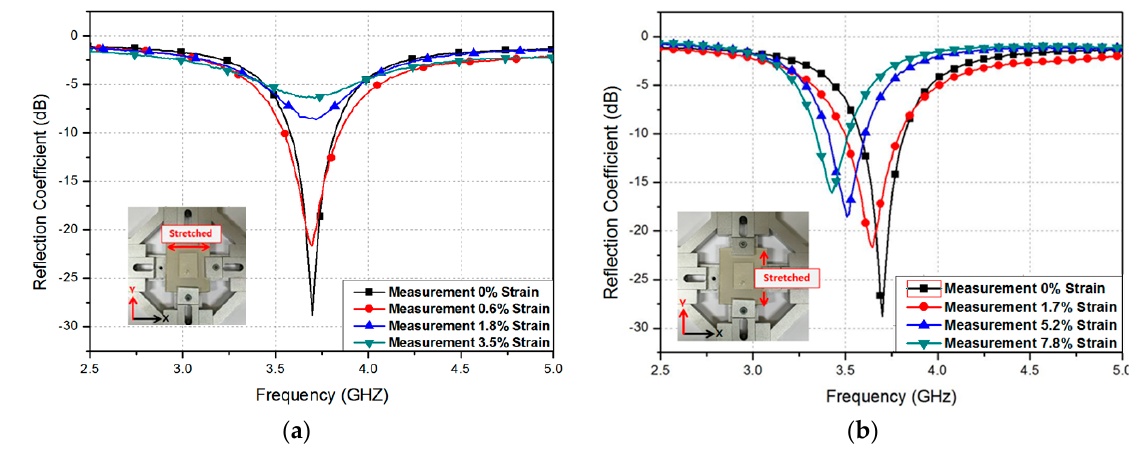
Figure 7. Measured reflection coefficients at different patch ( a ) widths and ( b ) lengths.